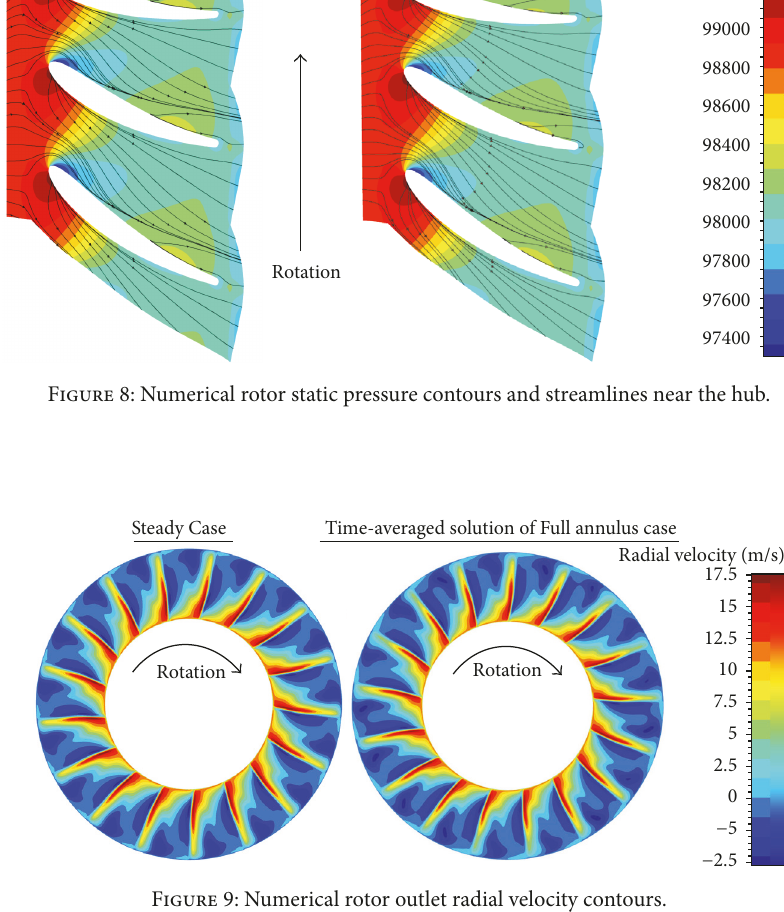
Figure 9: Numerical rotor outlet radial velocity